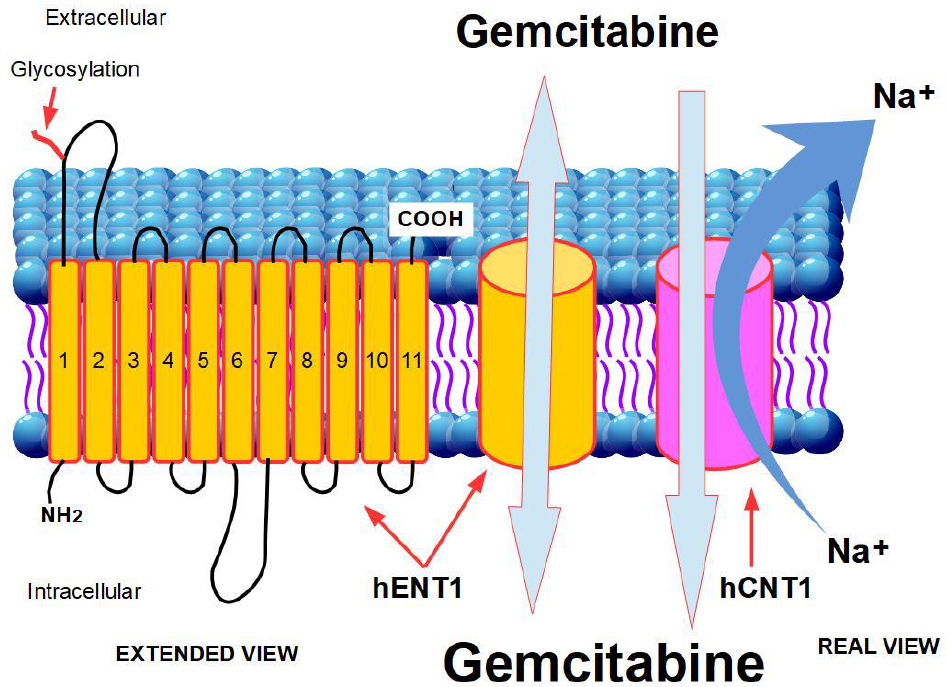
Figure 3. Mechanism of gemcitabine’s access to the cell. Gemcitabine membrane transporters. Greenhalf et al. [226] studieddifferencesinoverall survival among patients who un- derwent ablative surgery, with high and low expression of hENT1 (ESPAC3 trial). Their findings are shown in Table 1.